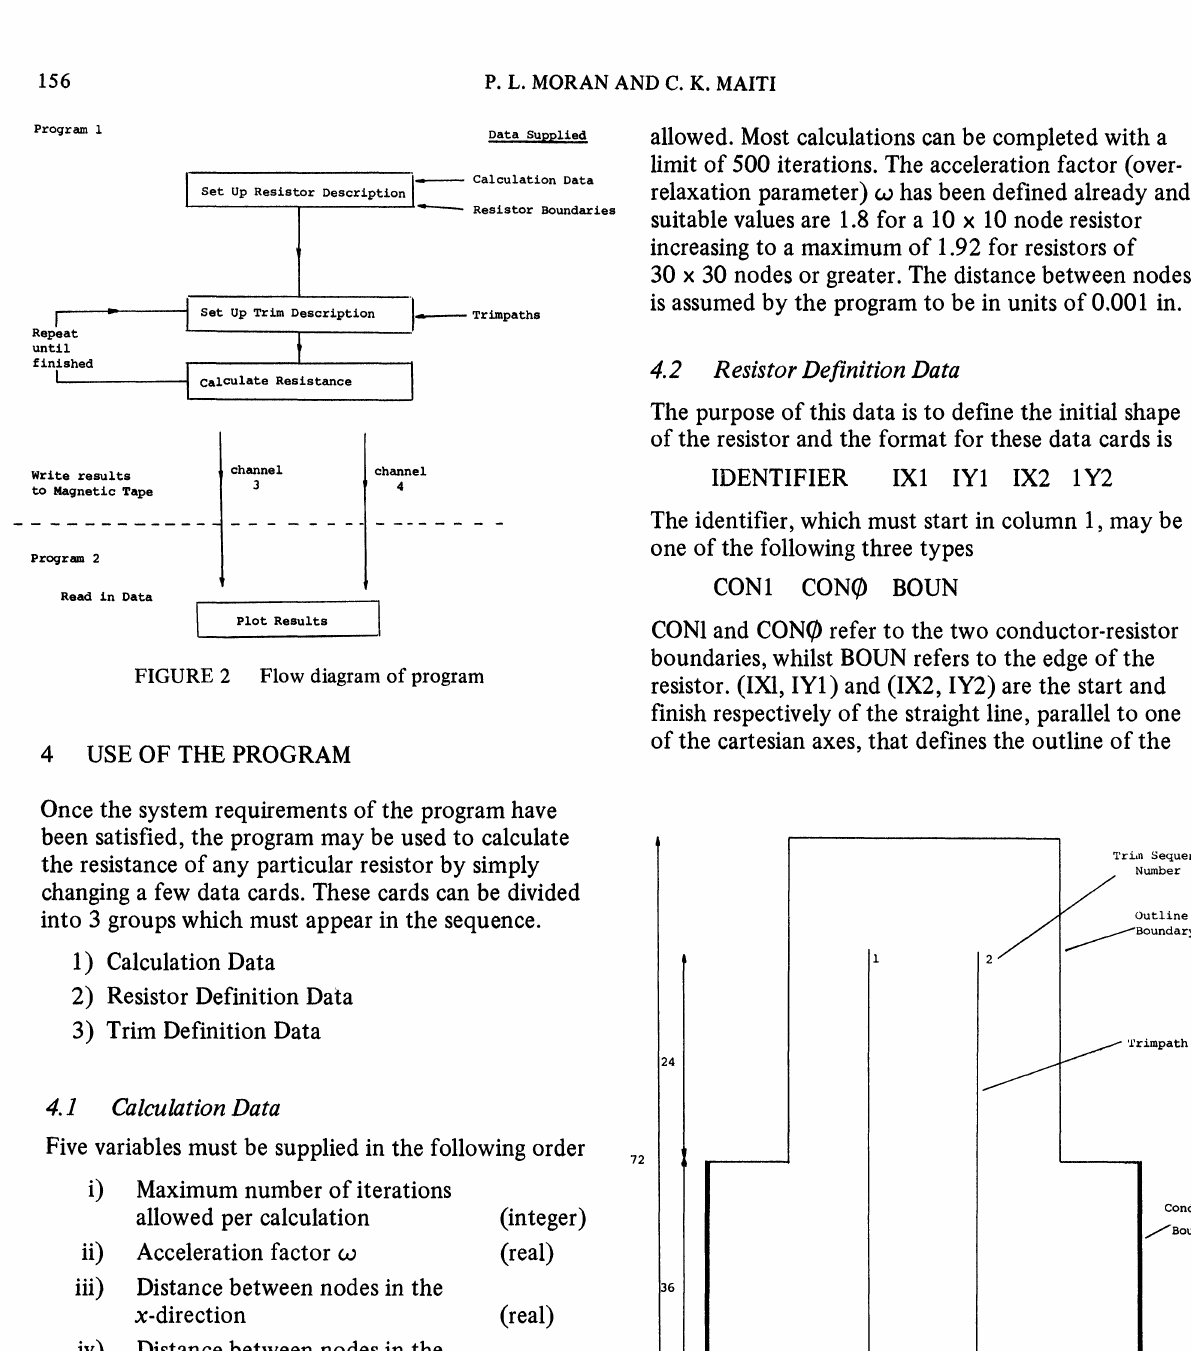
Conductor /Boundary